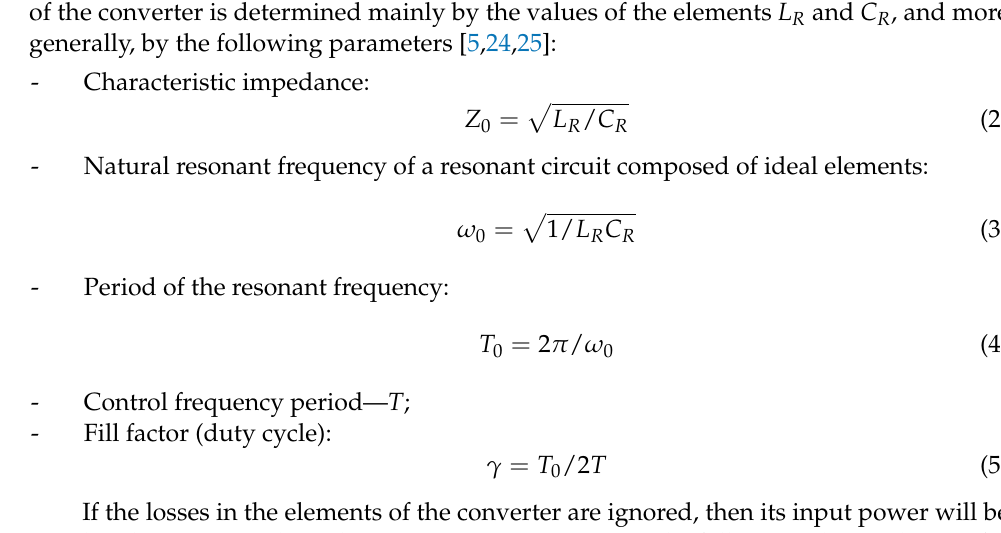
Figure 3. Modal diagram of a half-bridge DC–DC converter with energy dosing. In the analysis of the circuit, the secondary circuit is brought to the primary circuit; as a result of which, the output capacitor, the load and the transformer are replaced by a voltage source nU OUT , where n is the transformation coefficient ( n = W 1 /W 2 ). The behavior of the converter is determined mainly by the values of the elements L R and C R , and more